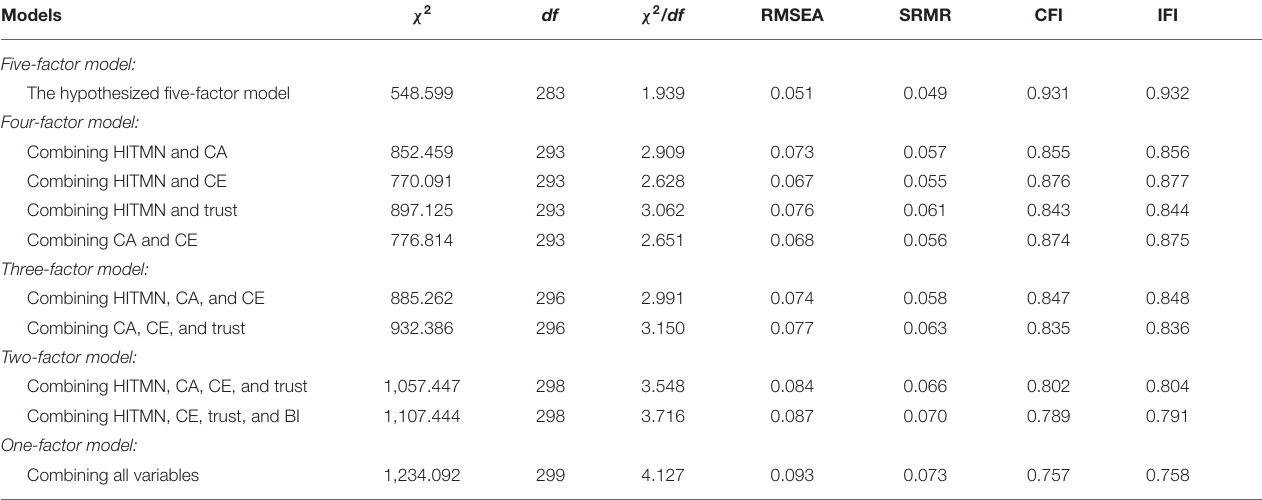
TABLE 1 | Confirmatory factor analysis model fit